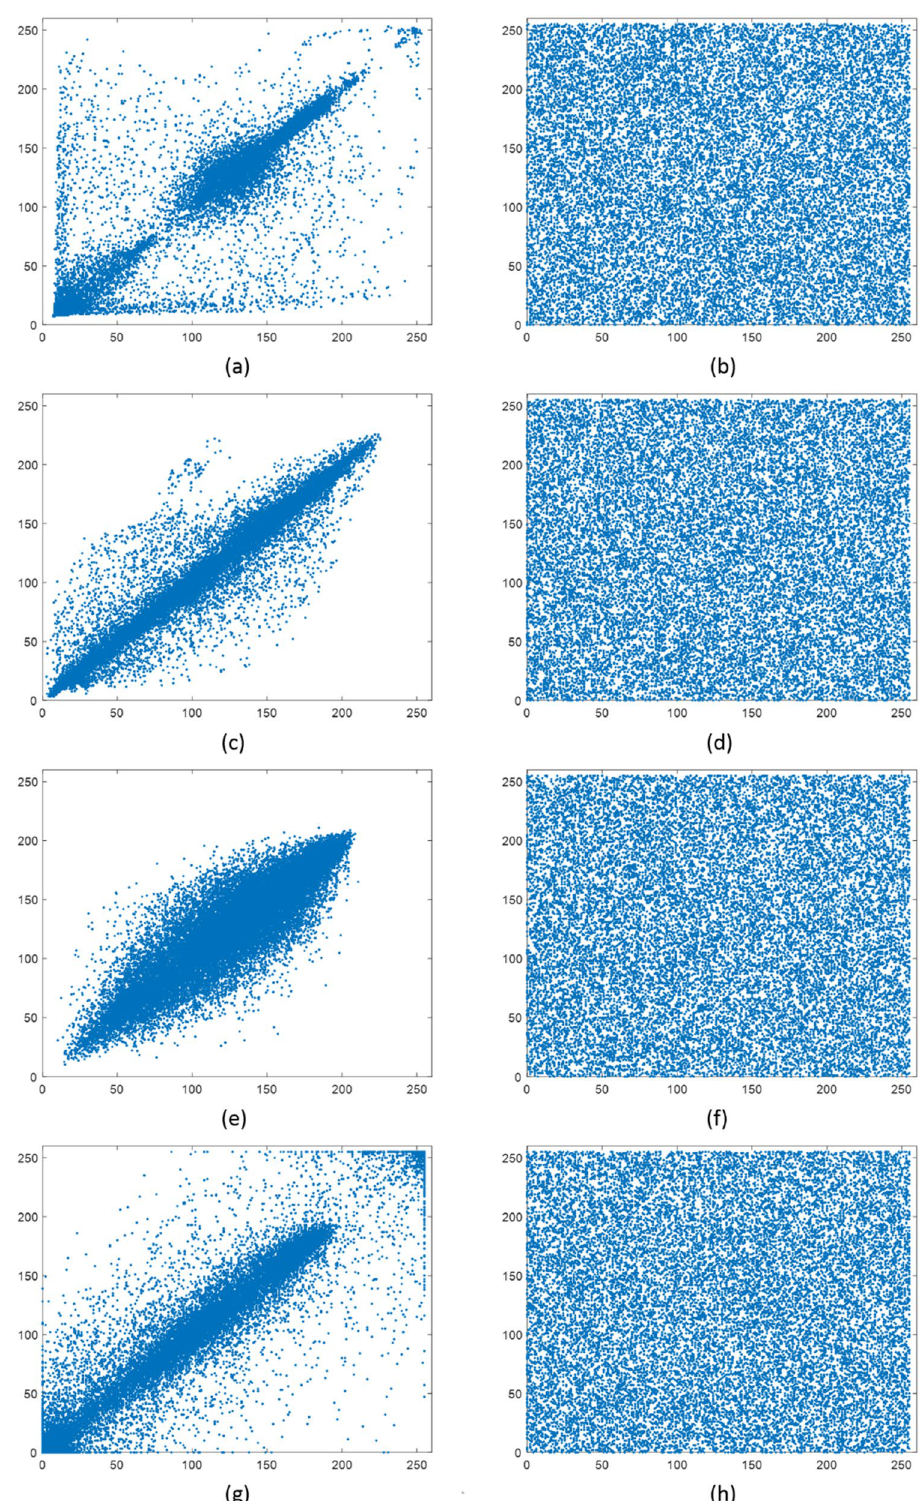
Figure 7. The correlation distribution of two adjacent pixels in the horizontal direction for the original and encrypted images. ( a ) Original “Cameraman”; ( b ) encrypted “Cameraman”; ( c ) original “Pepper”; ( d ) encrypted “Pepper”; ( e ) original “Baboon”; ( f ) encrypted “Baboon”; ( g ) original “Brain”; ( h ) encrypted